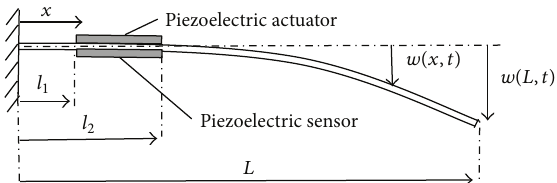
Figure 1: Beam with a piezoelectric actuator and a piezoelectric sensor.